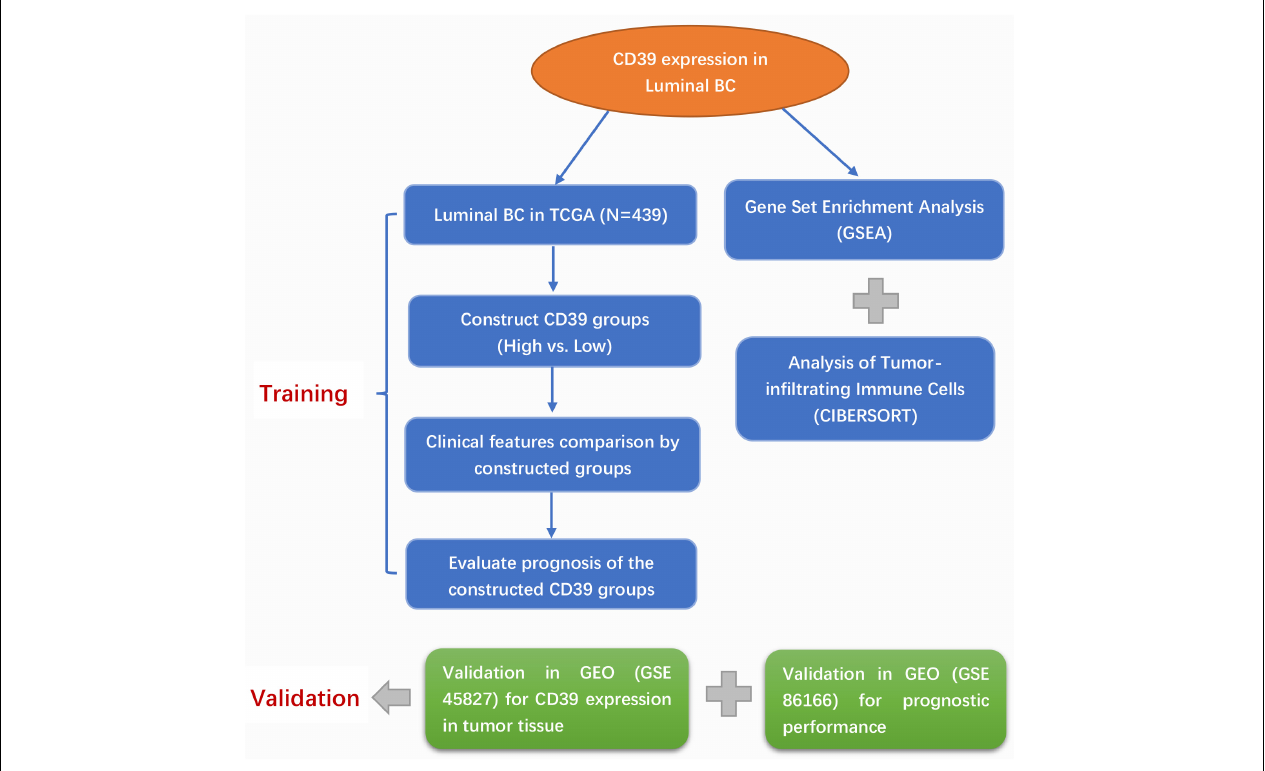
FIGURE 1 | Flow chart indicating the study design of the present